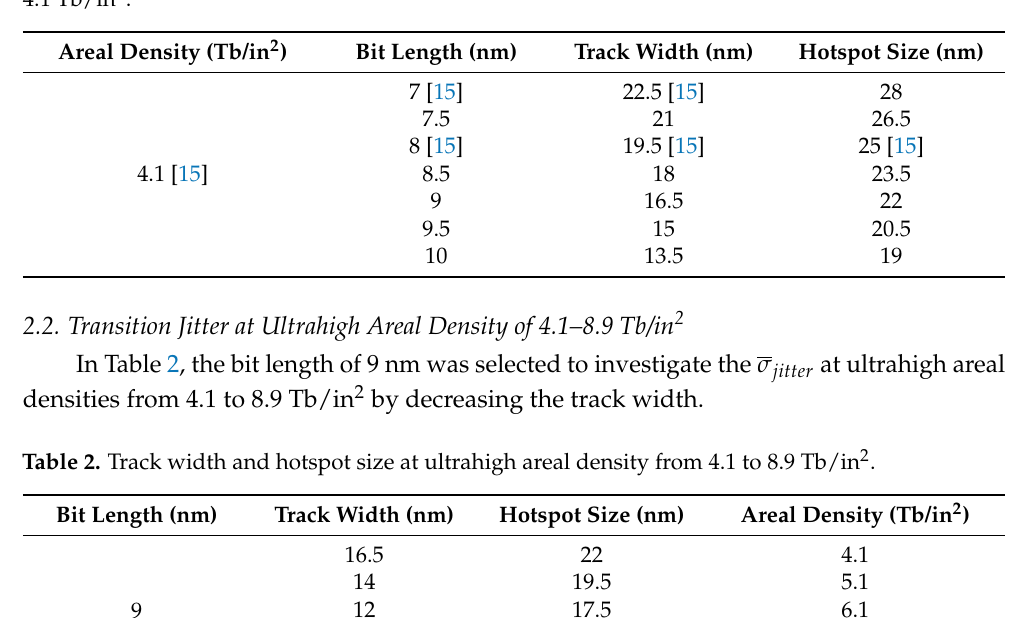
Table 1. Bit length, track width, and hotspot size use in the simulation at the areal density of 4.1 Tb/in 2 .